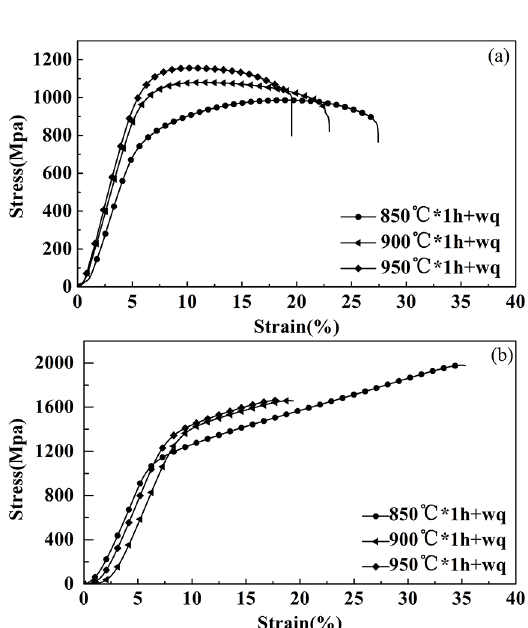
Figure 3. The four-dimensional diagrams of the Young's modulus of α' phase with different heat treatment temperature: (a ) Four-dimensional 1 diagrams and (a ) plane projections of Young's modulus of α' phase 2 after quenching at 850ºC; (b ) Four-dimensional diagrams and (b ) 1 2 plane projections of Young's modulus of α' phase after quenching at 900ºC; (c ) Four-dimensional diagrams and (c ) plane projections 1 2 of Young's modulus of α' phase after quenching at 900ºC.